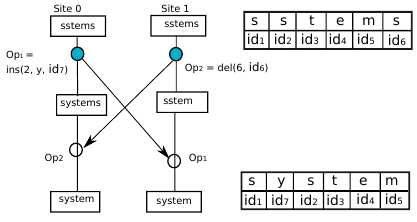
Figure 3. Integrate operation in CRDT